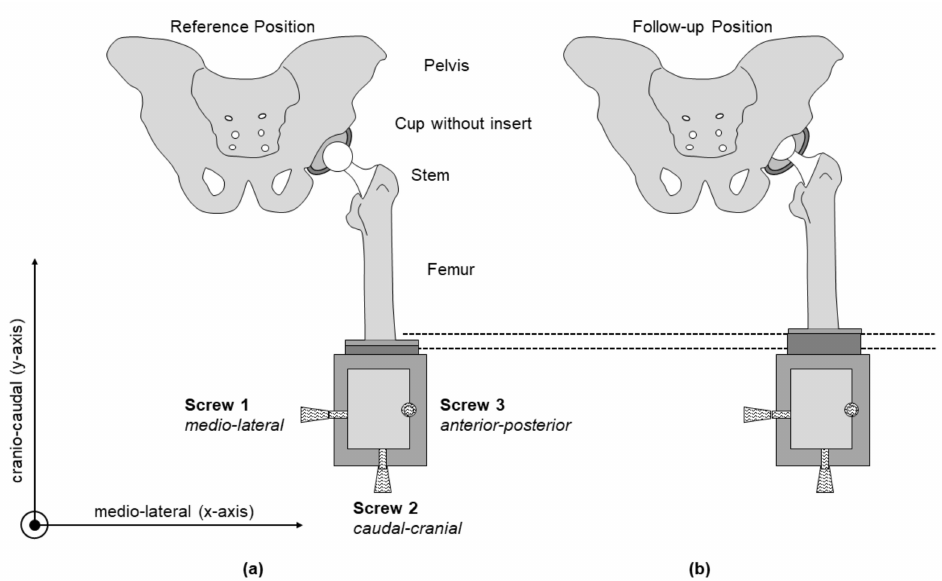
Figure 2. A schematic drawing of the implant-bone model with a femoral and pelvic element in ( a ) the reference position and ( b ) the follow-up position. The femoral part of the implant-bone model was moved according to the measurement protocol by the three screws (see Section 2.3). The alignment of the implant-bone model, as well as the wear simulation and pelvic positions, were performed according to the global coordinate system: medio-lateral axis ( x -axis), cranio-caudal axis ( y -axis), and anterior-posterior ( z